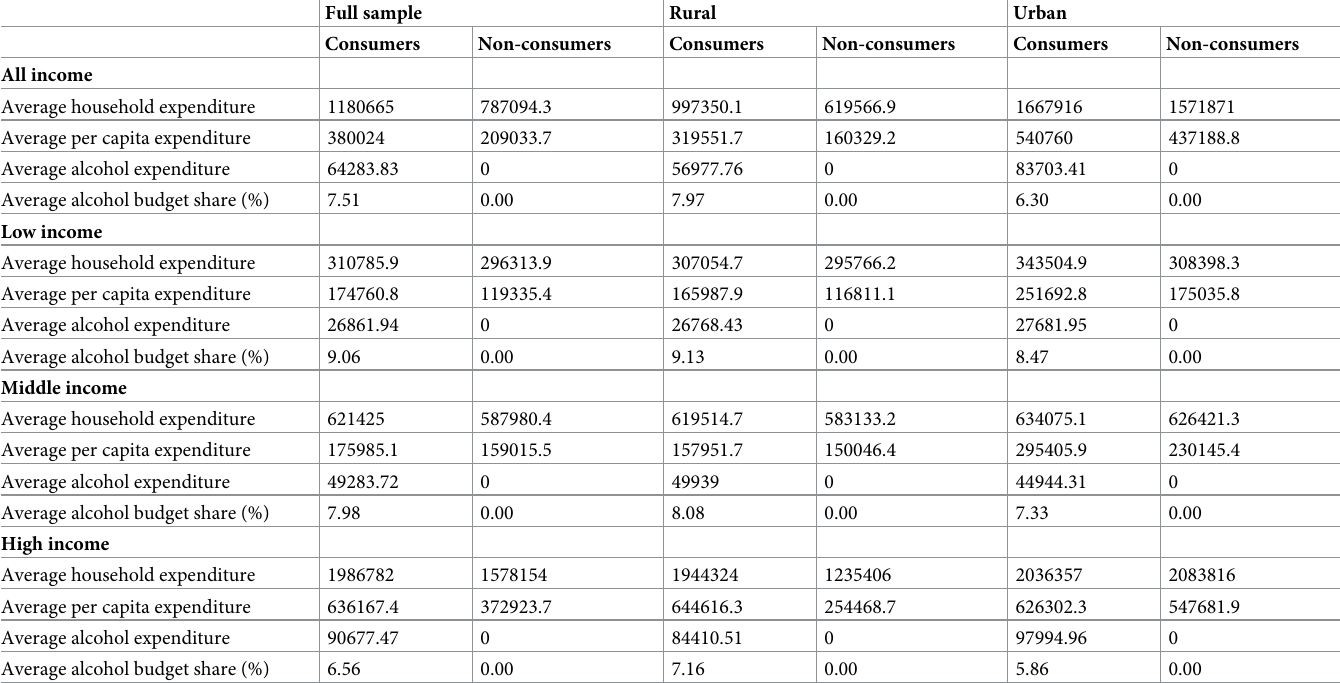
Table 1. Summary averages.